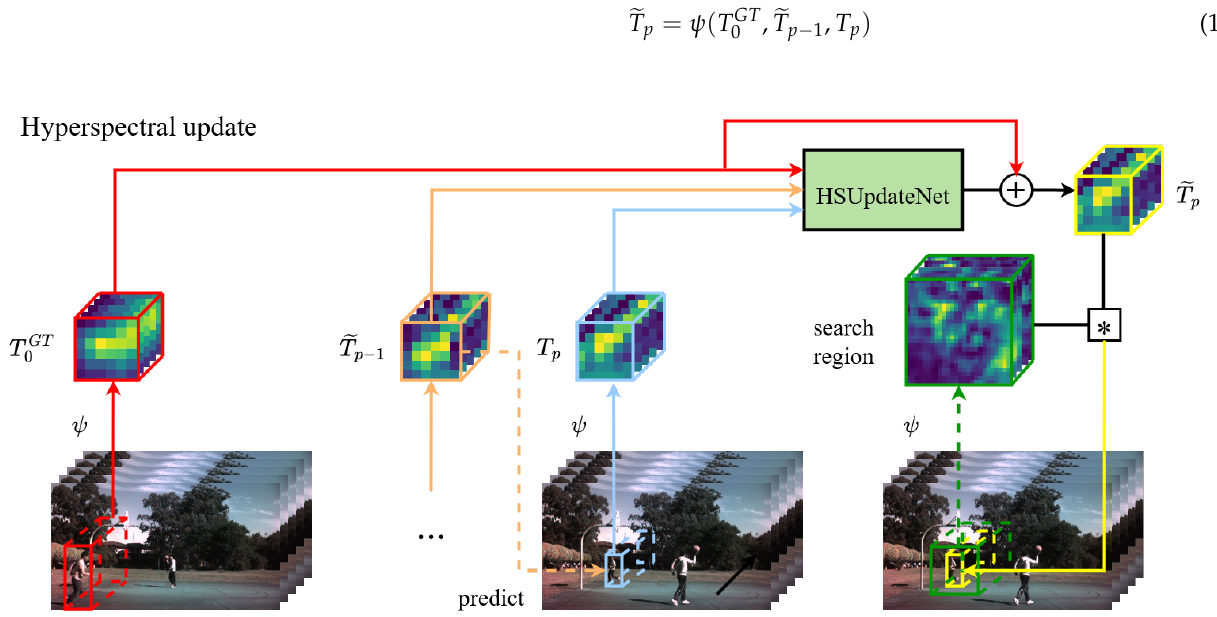
Figure 5. An overview of the tracking framework using